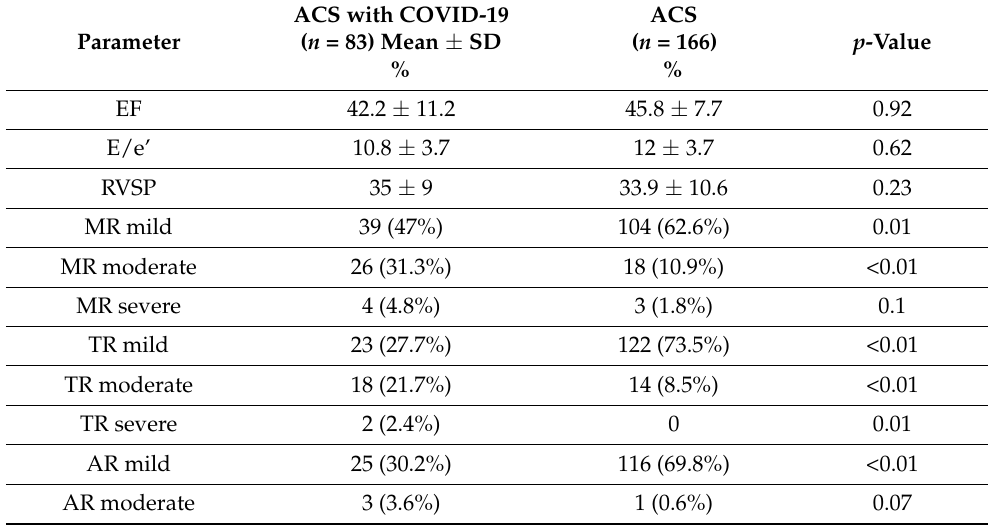
Table 4. Echocardiographic